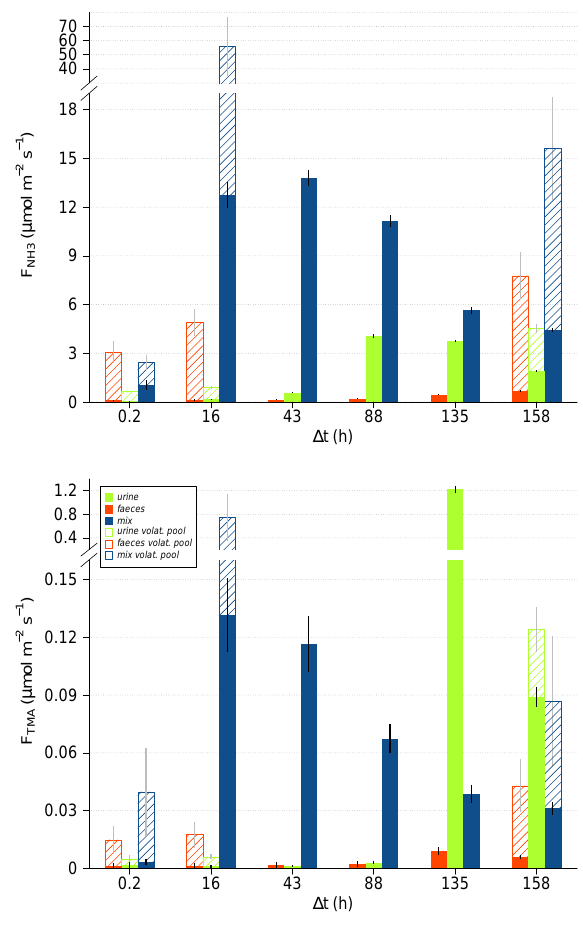
Figure 4. Dynamic chamber NH 3 and TMA emission rates from samples of urine, faeces, and their mixture, as well as emission rates from parallel samples with pH raised > 12 (“volatile emission pool”).